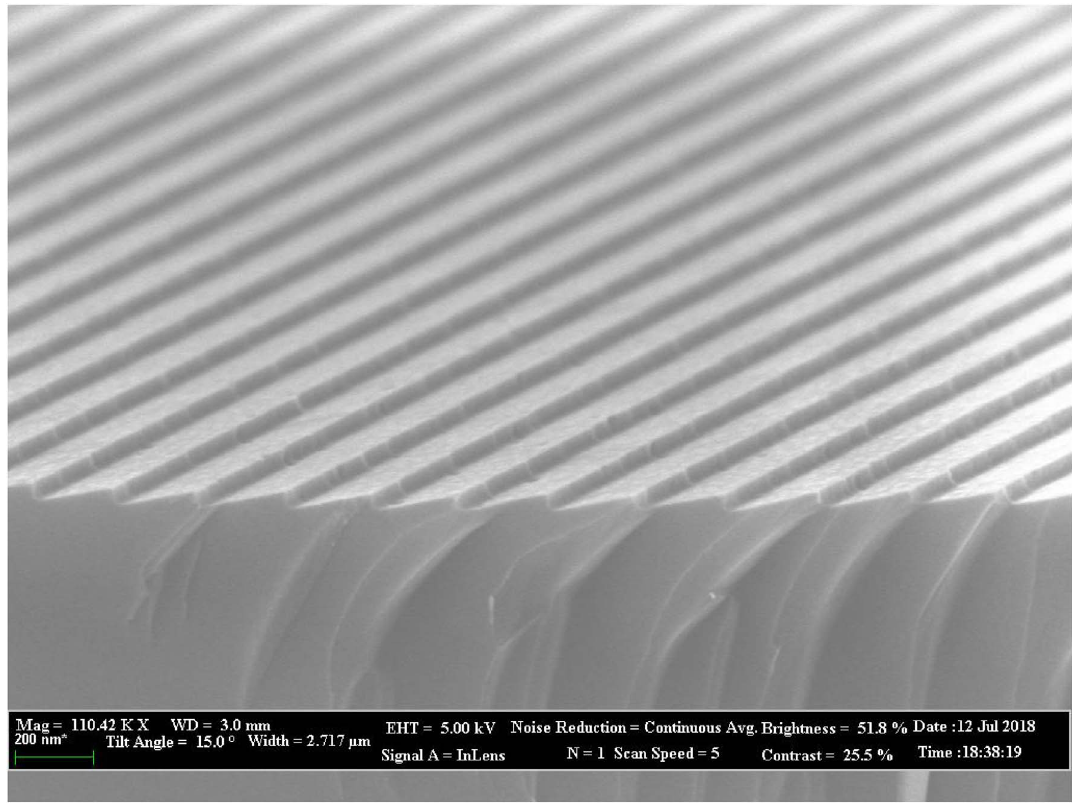
Fig. 8. Tilted scanning electron microscope image for a cleaved sample of a 5000 lines/mm blazed grating after 9 cycles of SC-I (5:1:1 DI: H 2 O 2 :NH 4 OH) and HF etching. The surface of each plane is smooth, and the etch is complete. (Photo courtesy Izentis